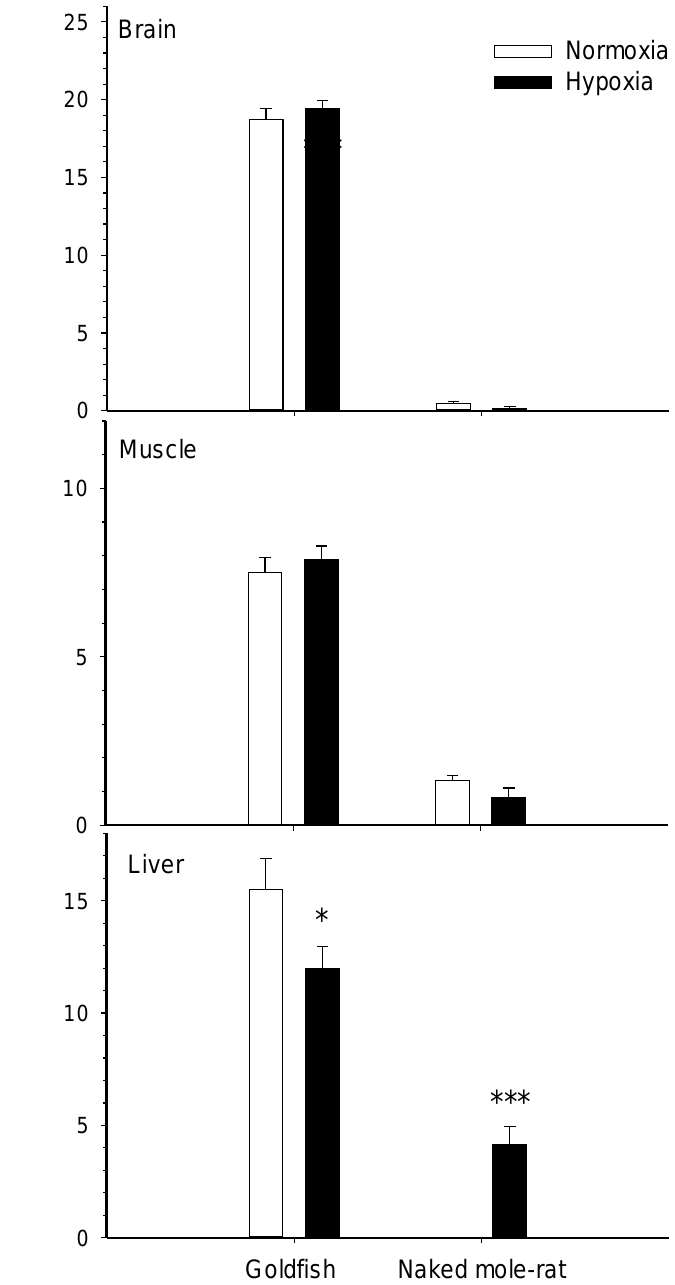
Figure 2. Percent docosahexaenoic acid (n-3 22:6) in membrane phospholipids in the tissues of normoxic controls and hypoxia-acclimated animals for two hypoxia-tolerant vertebrates: the gold- fish [14] and the naked-mole rat [15]. Values are means ± SEM ( n = 9–14 per treatment). * p < 0.05, *** p < 0.001 indicate significant effects of hypoxia.